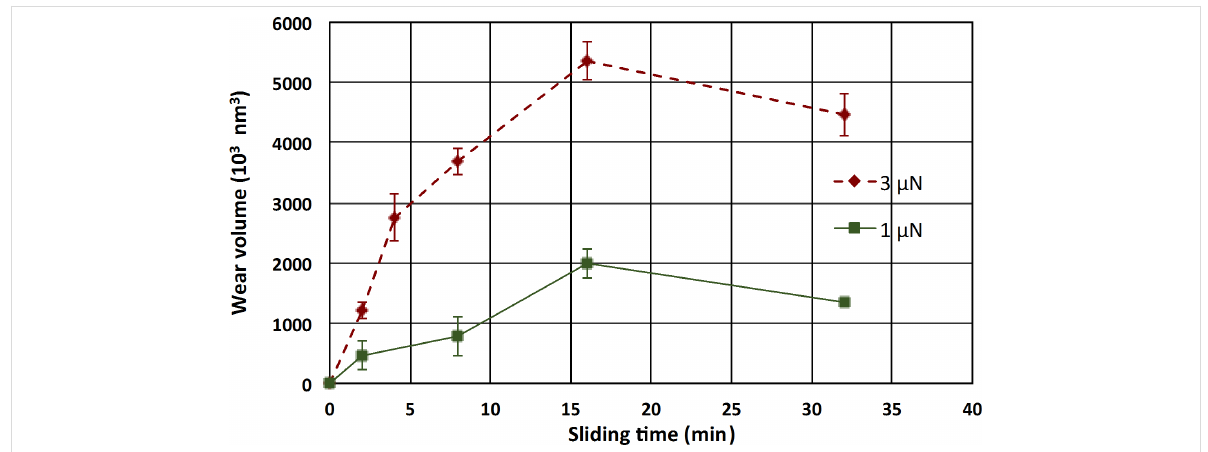
Figure 5: Wear volume as a function of the sliding time at a sliding velocity of 880 µm/s and a normal load of 1 µN (green squares) and 3 µN (red diamonds). Experiments were carried with a diamond-like carbon (DLC) probe. Error bars are the standard deviation and the data result from an aver- age between the maximum wear volume and the minimum wear volume issued from the calculation described in the Experimental